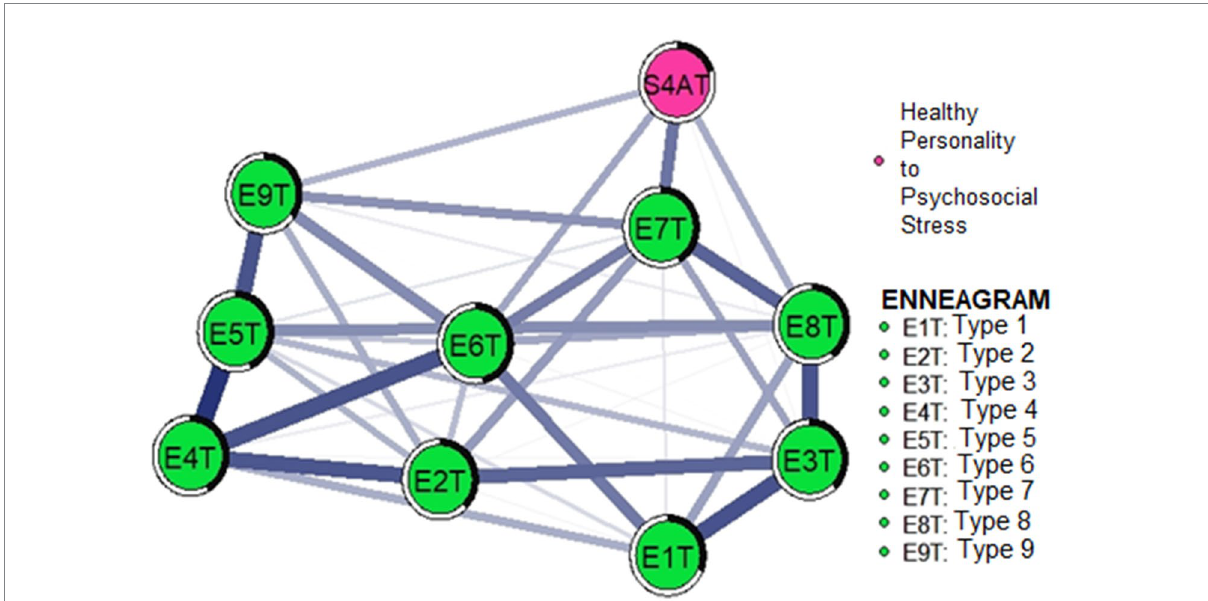
FIGURE 1 Network analysis of the nine personality types of the Enneagram and healthy personality to psychosocial stress. The greater the thickness of the observed connections, the greater the magnitude of the statistical relationships. It should be specified that the thickness of the line equals the magnitude of the